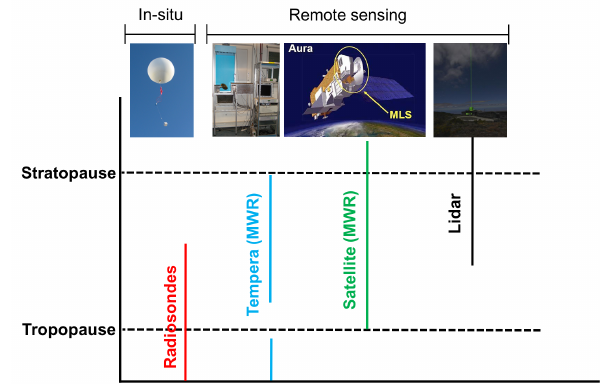
Figure 3. Measurement ranges for the different techniques used in this study (radiosondes, Tempera radiometer, MLS and